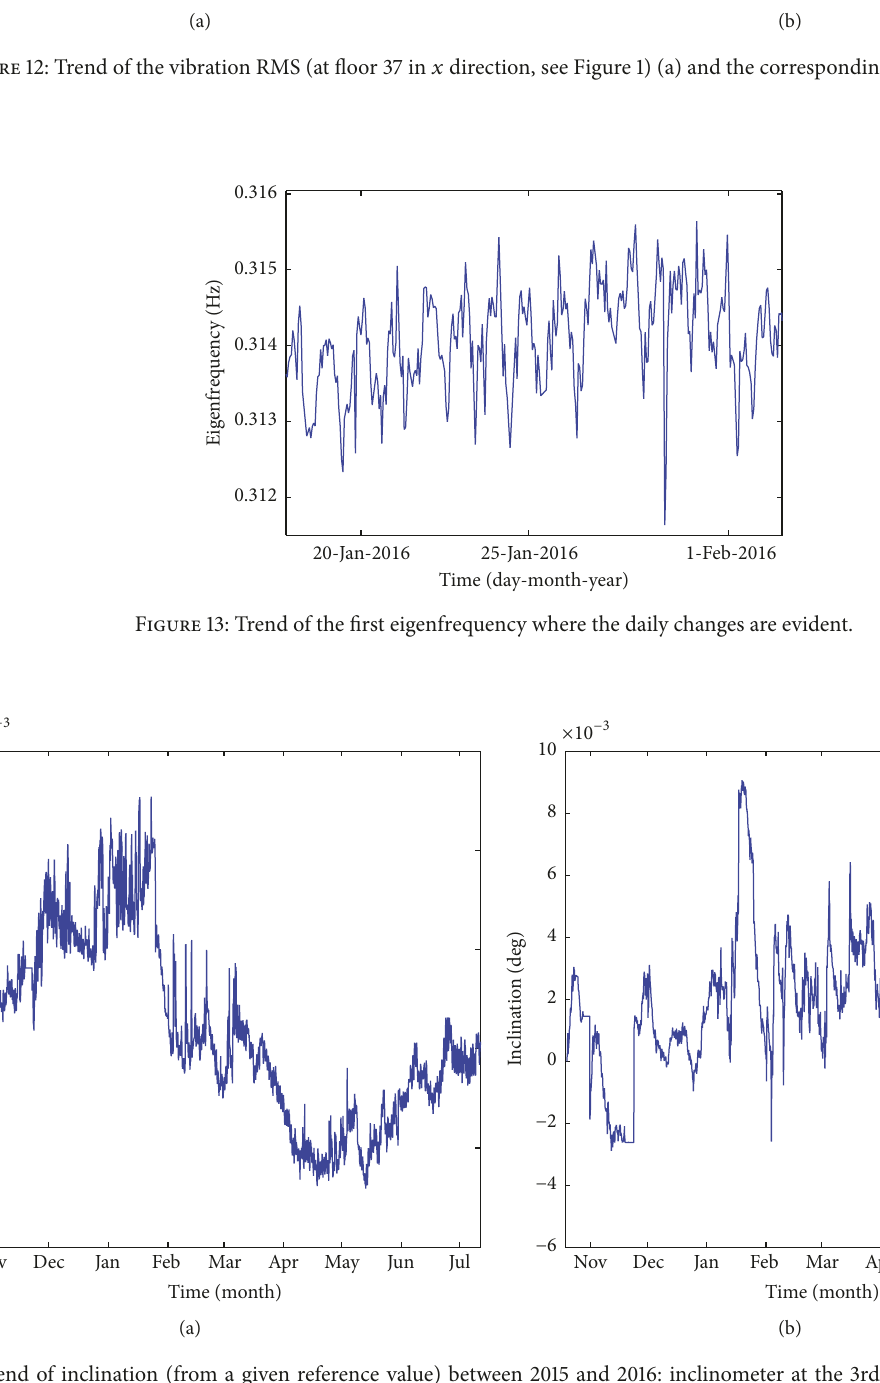
Figure 14: Trend of inclination (from a given reference value) between 2015 and 2016: inclinometer at the 3rd floor underground of the building in east-west direction (a) and at the 30th floor of the building in east-west direction